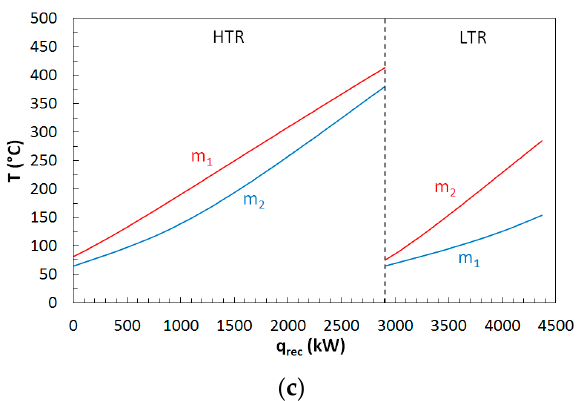
Figure 18. Temperature heat–load diagrams of the heat transfer between hot and cold CO 2 in the recuperator/s of the s-CO 2 power cycles: ( a ) Single flow split with dual expansion; ( b ) partial heating; ( c ) dual recuperated.